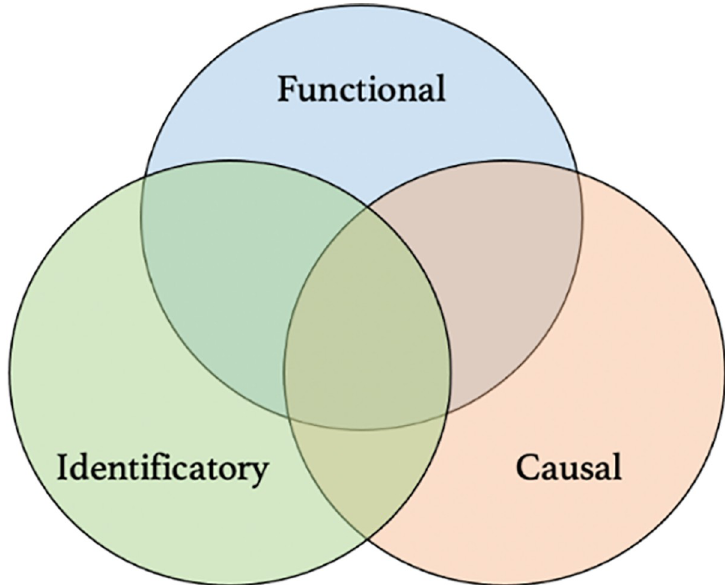
Fig 1. Three different approaches to immunological exhaustion. These approaches use different criteria and do not always